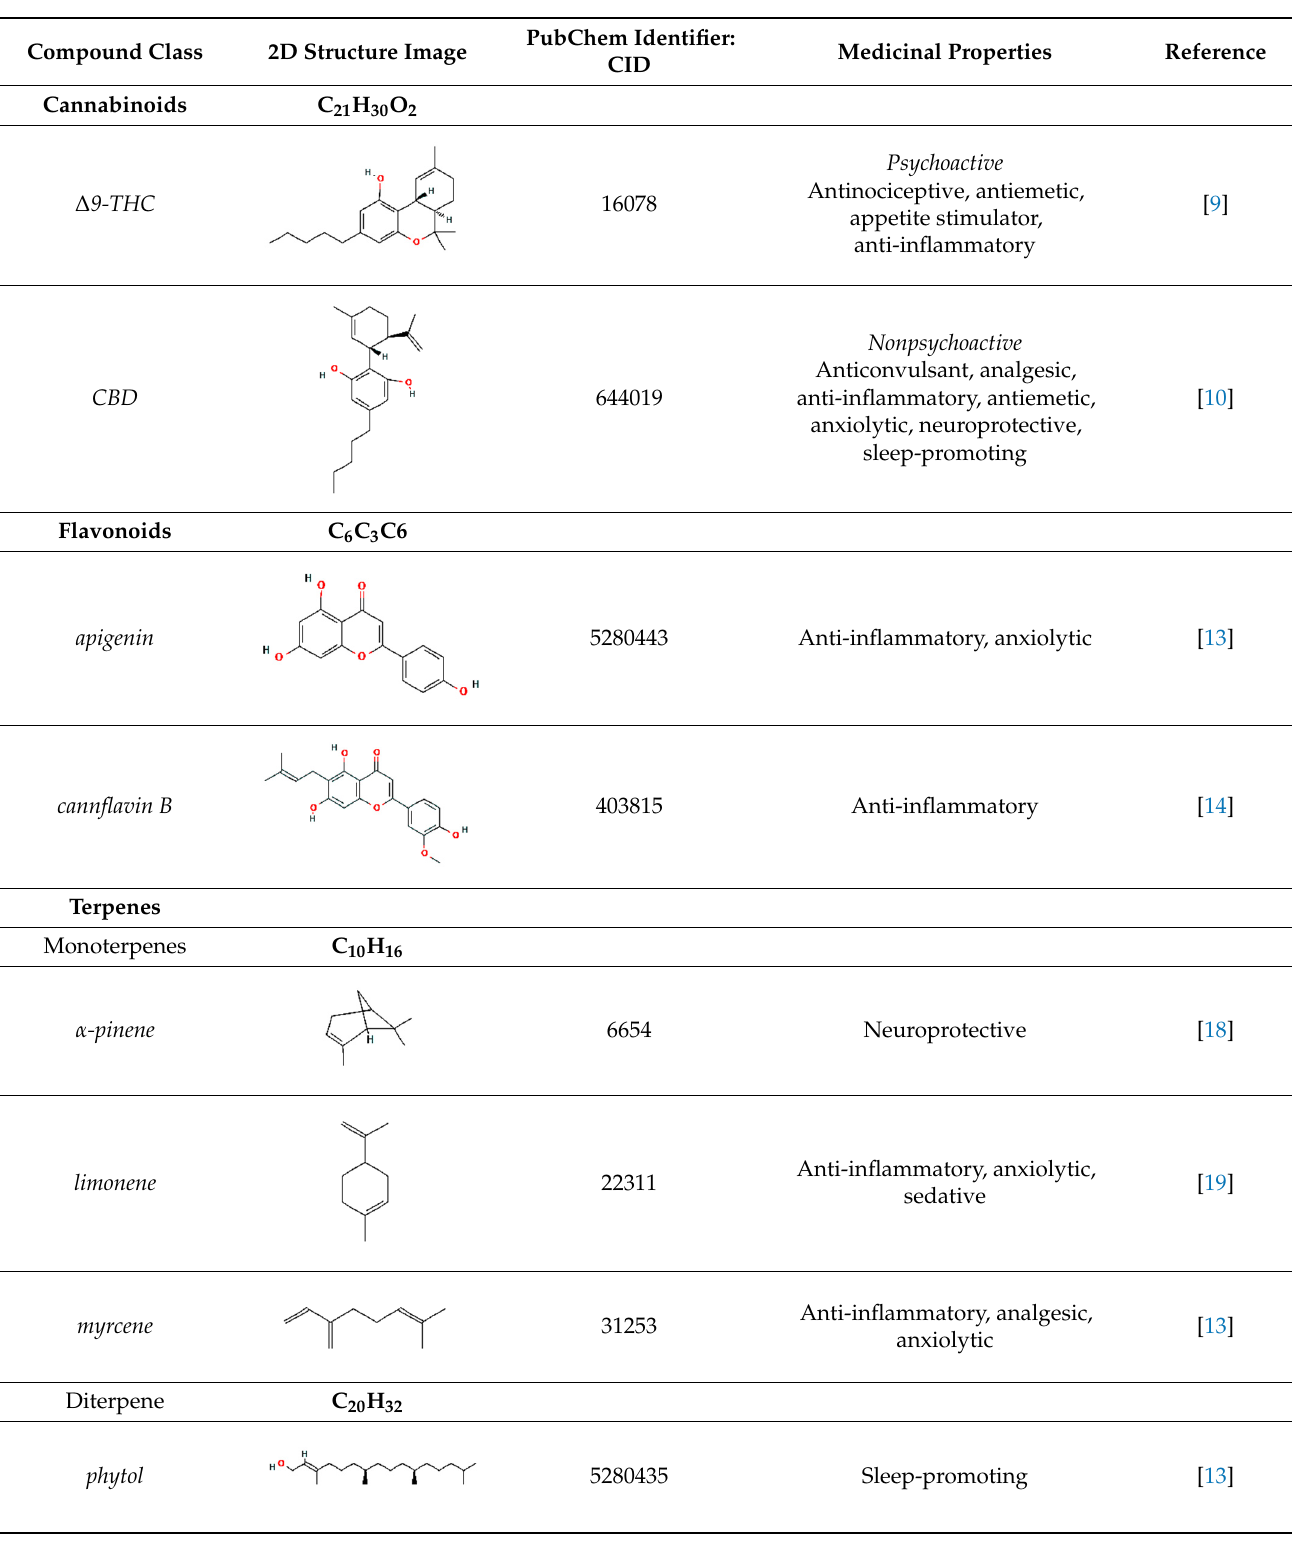
Table 1. Main classes of compounds of Cannabis sativa (2D structure images are available at https: